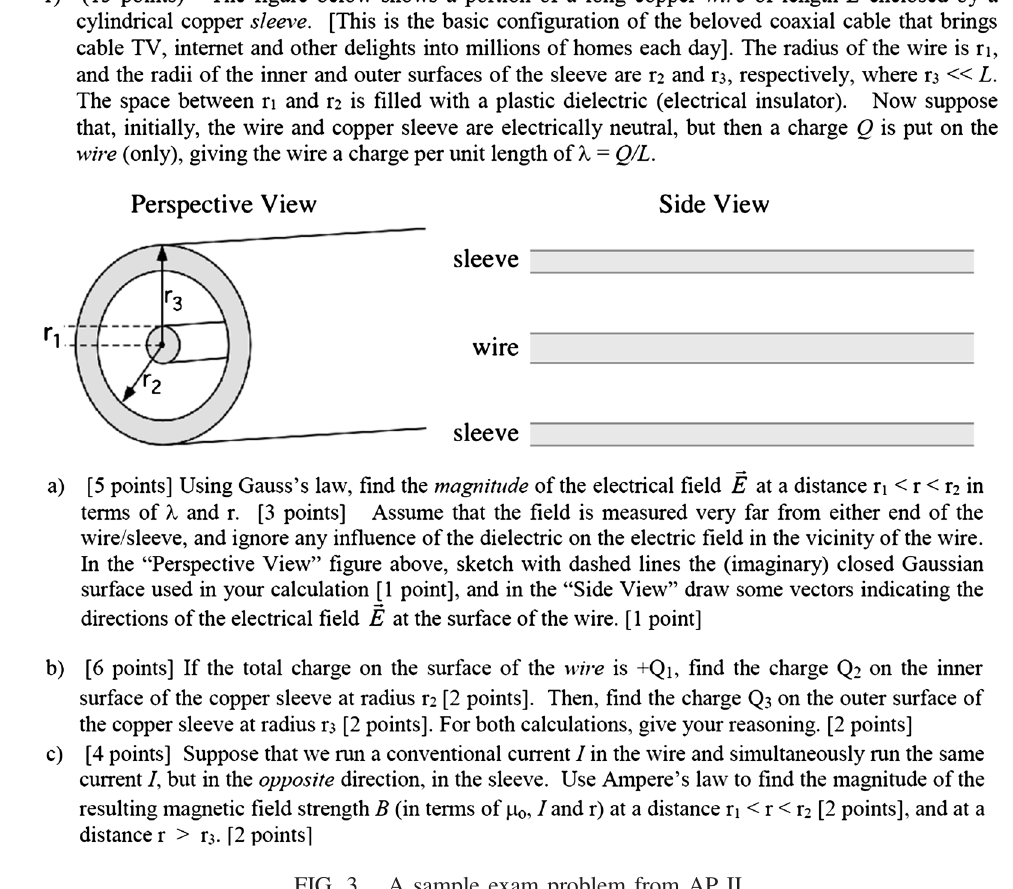
FIG. 3. A sample exam problem from AP II.